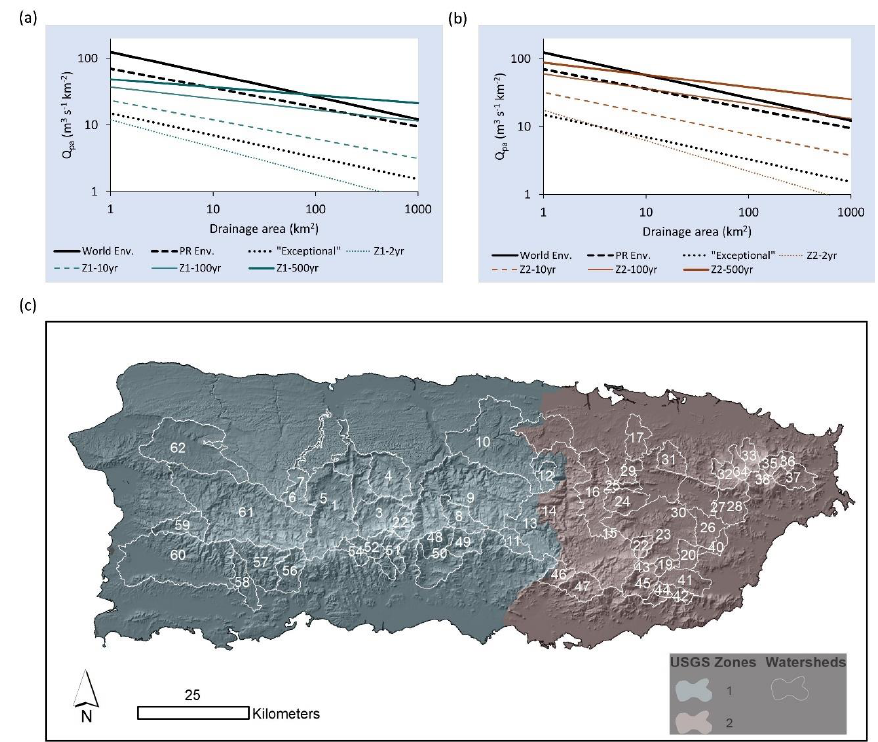
Figure 2. Comparison of the world’s and Puerto Rico’s flood envelope [40] to the island’s latest magnitude-frequency estimates [42]. ( a ) Drainage area versus area-normalized peak flows (Q pa ) for Zone 1 (western region). ( b ) Drainage area versus Q pa for Zone 2 (eastern region). ( c ) Map showing the spatial extent of Zones 1 and 2 according to [42] and the location of the watersheds for which Q pa values were available for Hurricane Fiona. Table 1. List of U.S. Geological Survey stations in Puerto Rico that recorded instantaneous peak flow rates during Hurricane Fiona. Map Station ID Num.